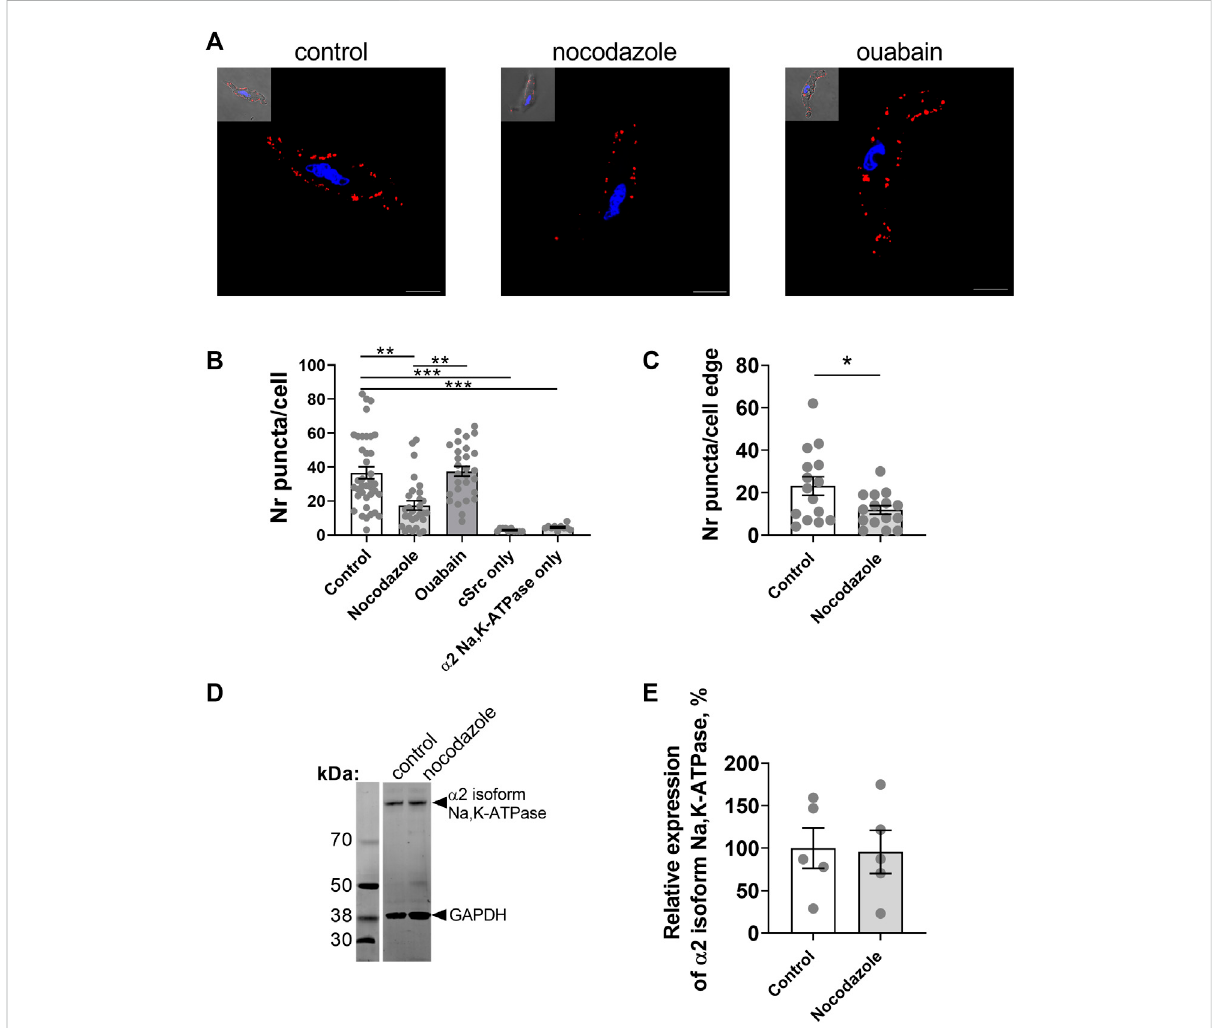
FIGURE 5 The interaction between the α 2 isoform Na,K-ATPase and Src kinase in freshly isolated smooth muscle cells from rat mesenteric small artery is controlled by microtubule network. Representative images of proximity ligation assay in myocytes under control conditions and treated with either nocodazole(10 µM)orwithouabain(10 µM)[ (A) ;scalebar=10 µm].Redpunctaeindicateacloseproximity( < 40 nm)betweenthe α 2isoformNa,K- ATPase and Src kinase. Nuclei are stained with DAPI and shown inblue. Quanti fi cation of thered punctaein theexperimentas in(A) is shown in [ (B) ;10 – 37cellsfrom3 – 4rats].Atthecelledgenocodazolesigni fi cantlydecreasedtheredpunctaeincomparisonwiththecontrol[ (C) ;15cellsfrom 3 rats]. Representative Western blot with rat mesenteric arteries lysates for the α 2 isoform Na,K-ATPase under control conditions and treated with nocodazole (D) . GAPDH protein was stained for loading control. Quanti fi cation of the α 2 isoform Na,K-ATPase expression under control conditions and after incubation with nocodazole[ (E) ; n = 5]. *, ** and ***, denote p < 0.05, 0.01 and 0.001, respectively (Kruskal – Wallis ’ test followed by Dunn ’